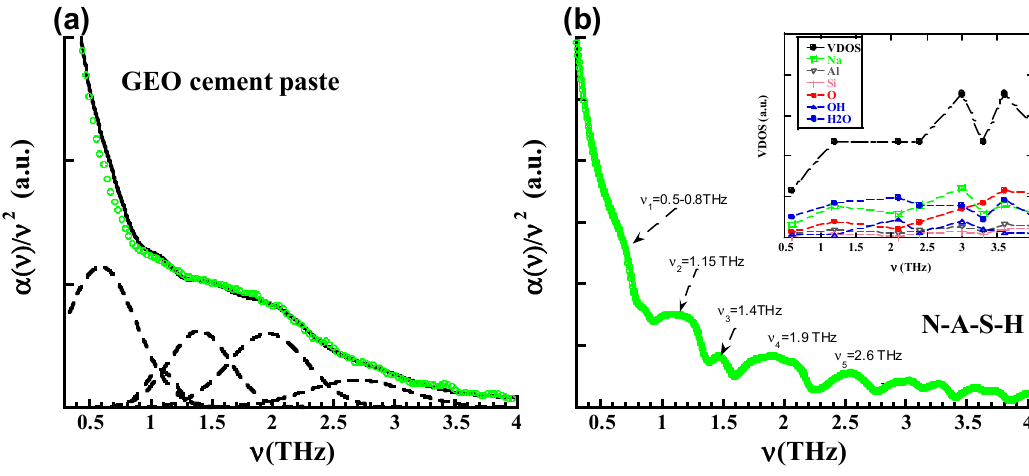
Figure 4. ( a ) Experimental absorbance of the geopolymer cement paste, together with the deconvolution of the spectra. ( b ) Computational prediction of the absorbance for the N-A-S-H model. In the inset the VDOS and their projections are